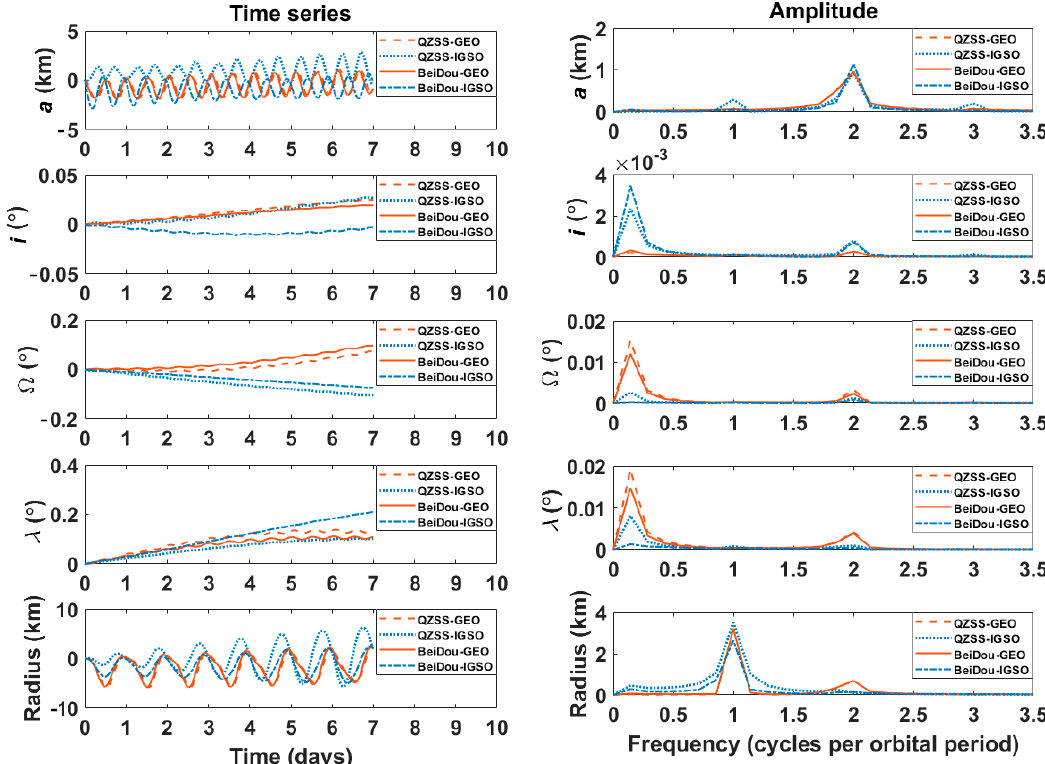
Figure 1. Time variation ( left ) and amplitude spectrum ( right ) of orbital elements: BeiDou geosynchronous (GEO)-C01, BeiDou inclined geosynchronous (IGSO)-C16, QZSS GEO-J01, and QZSS IGSO-J07 satellites.